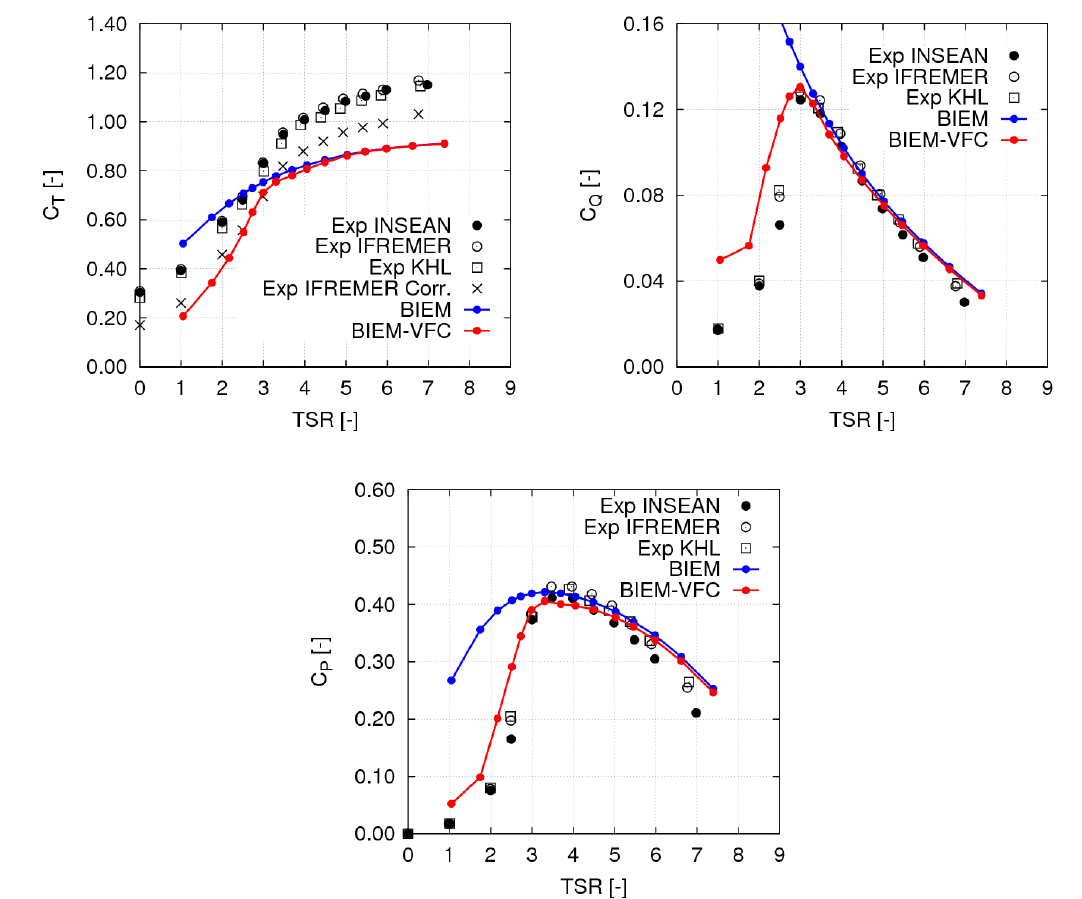
Figure 12. IFREMER-FP turbine performance predictions by BIEM and BIEM-VFC compared to experimental data in [11]: thrust ( top left ); torque ( top right ) and power ( bottom )